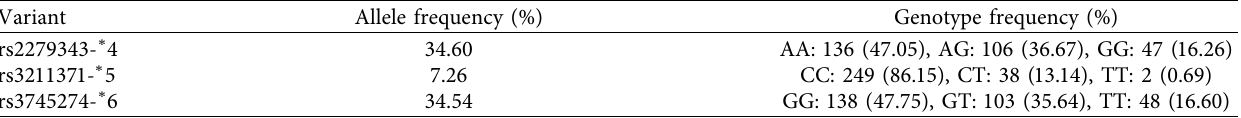
Table 3: The allele and genotype frequencies of CYP2B6 ∗ 4, ∗ 5, and ∗ 6 in Mazani ethnic people ( n � 289).